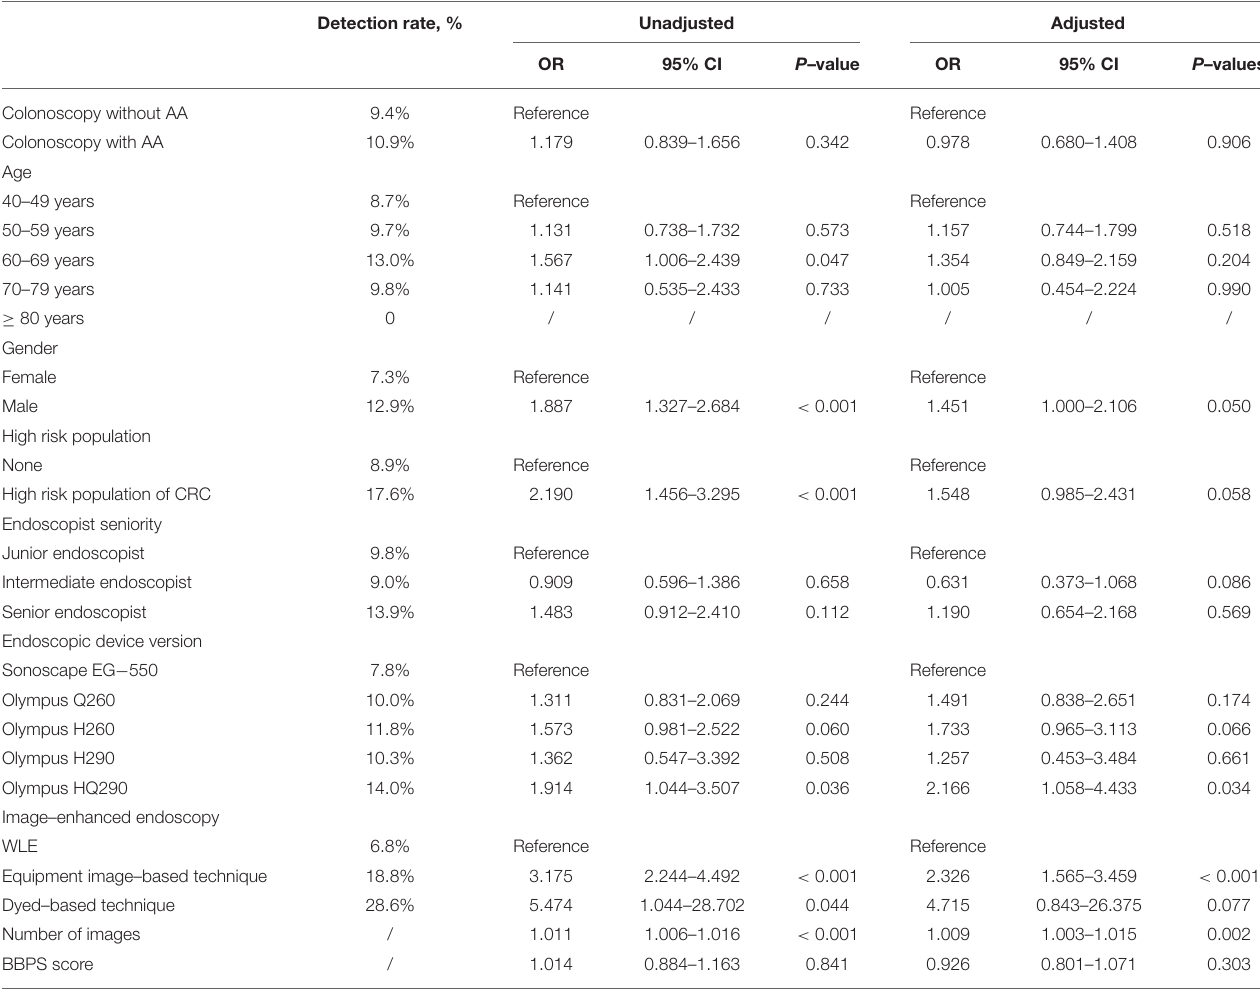
TABLE 3 | Logistic regression analysis for ADR in the propensity-matched cohort. Detection rate,